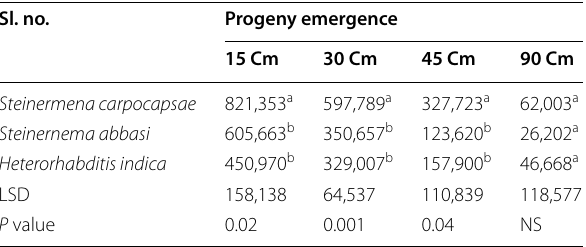
In a column with different alphabet letter were significantly different at Tukey’s HSD at P < 0.05